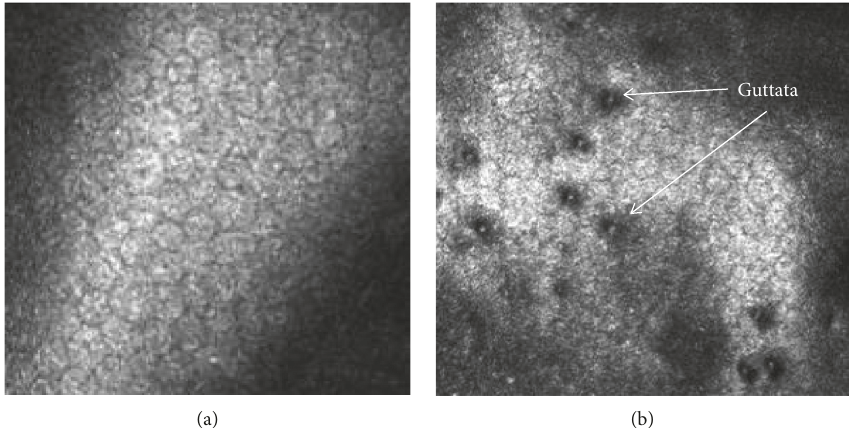
Figure 1: Confocal microscopy of corneal endothelial cells. (a) Normal endothelial cells with a regular hexagonal shape. (b) Fuchs endothelial corneal dystrophy shows a loss of defined hexagonal shape, increased cell size, and the formation of guttata (as